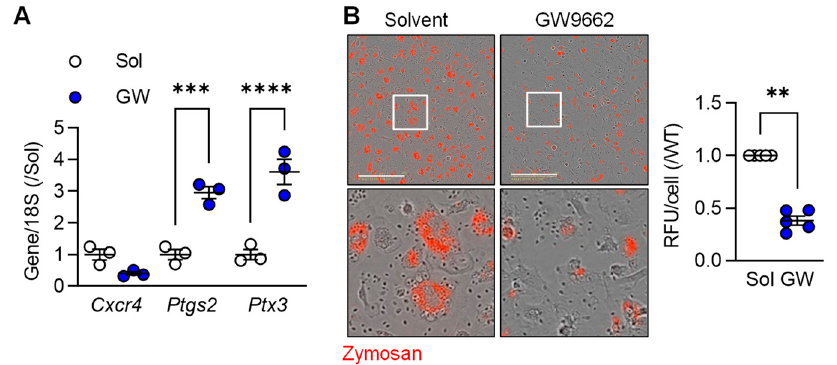
Figure 2. M2c macrophage polarization relies on PPAR γ activation. ( A ) Expression of Cxcr4 , Ptgs2 and Ptx3 in M2c polarized macrophages from wild-type mice treated with solvent (0.1% DMSO) or the PPAR- γ antagonist; GW9662 (10 µmol/L) 2 h prior to the addition of TGF- β ( n = 3 independent experiments, Student’s t test). ( B ) Zymosan phagocytosis by M2c macrophages treated as in A. Images were taken 30 min after zymosan addition and the white boxes indicate the area magnified in the lower panels; bar = 200 µm ( n = 5/group, Kruskal–Wallis rank sum test). ** p < 0.01, *** p < 0.001, **** p < 0.0001.